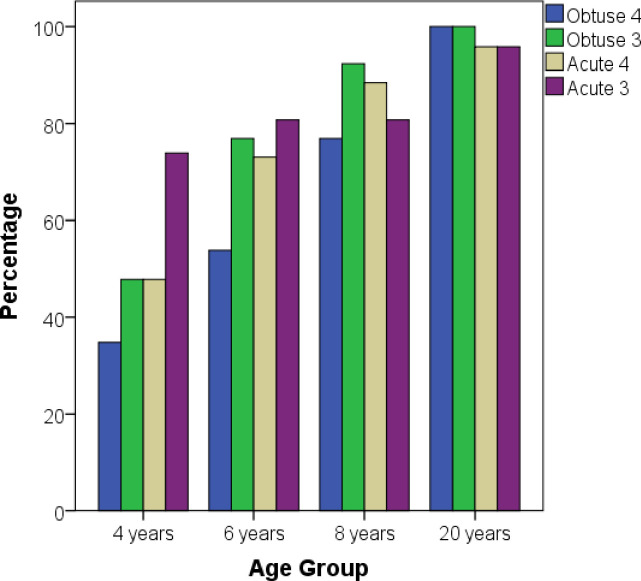
Percentage of success in preserving angle.